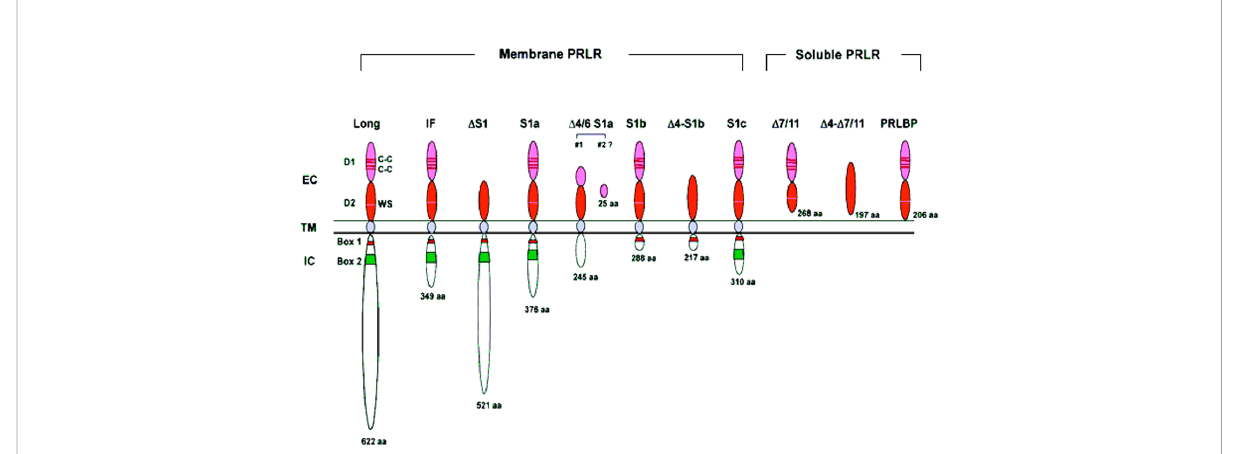
FIGURE 3 Structure of human PRLR variants. LF, long form; IF, intermediate form; S1a, S1b & S1c, short forms; PRLBP, prolactin binding protein; LF D S1, long form lacking D1 domain; LF D S2, long form lacking D2 domain; D , deleted exon. D1, D2, N-terminal subdomain; WS, WSXWS motif; C,